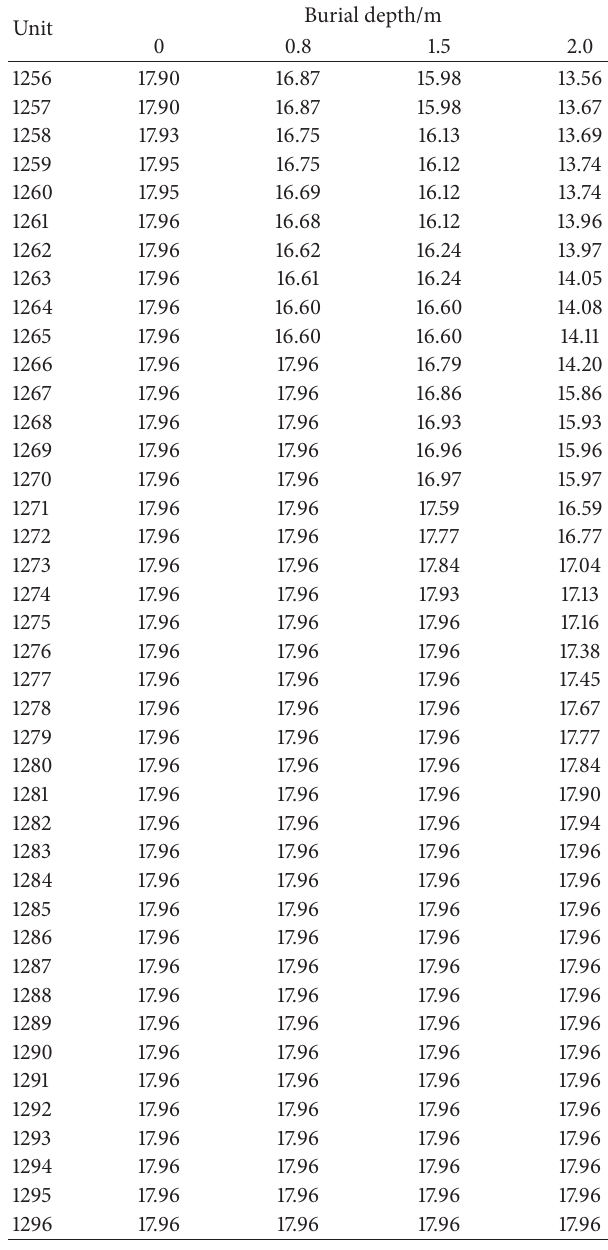
Table 1: Horizontal stiffness of each unit for pier 78 at different depths